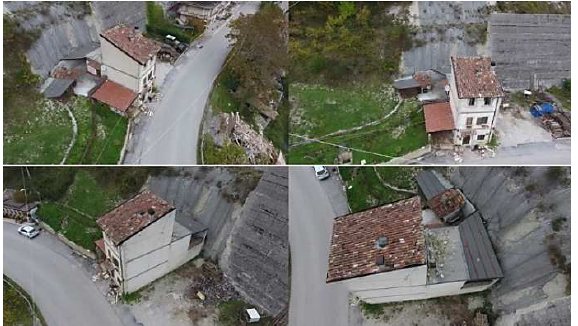
Figure 7. Some frames extracted from 4K video by DJI camera